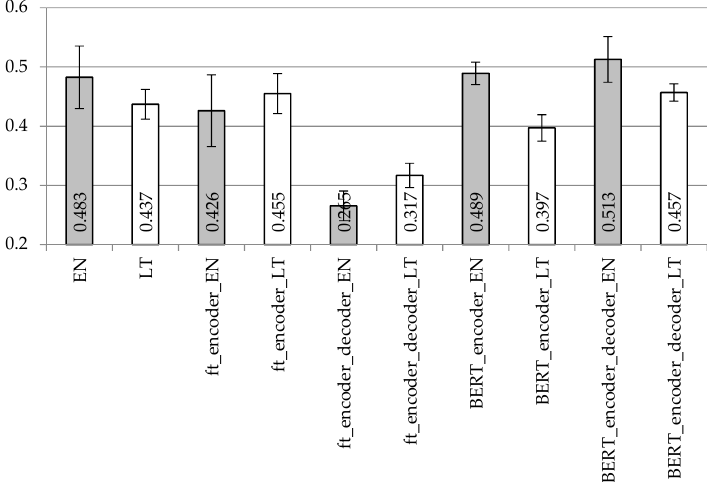
Figure 9. Averaged BLUE scores with confidence intervals using BiLSTM encoder and LSTM decoder model with different vectorization types on the dataset with removed punctuation.